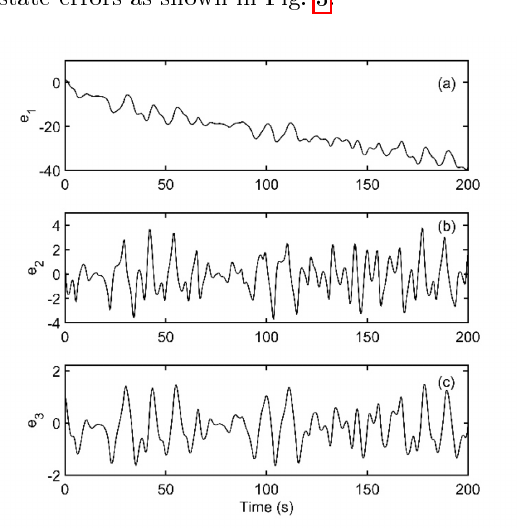
Fig. 3: The state errors between master and slave with- out control e(cid:27)ects. Second, the coupled systems are